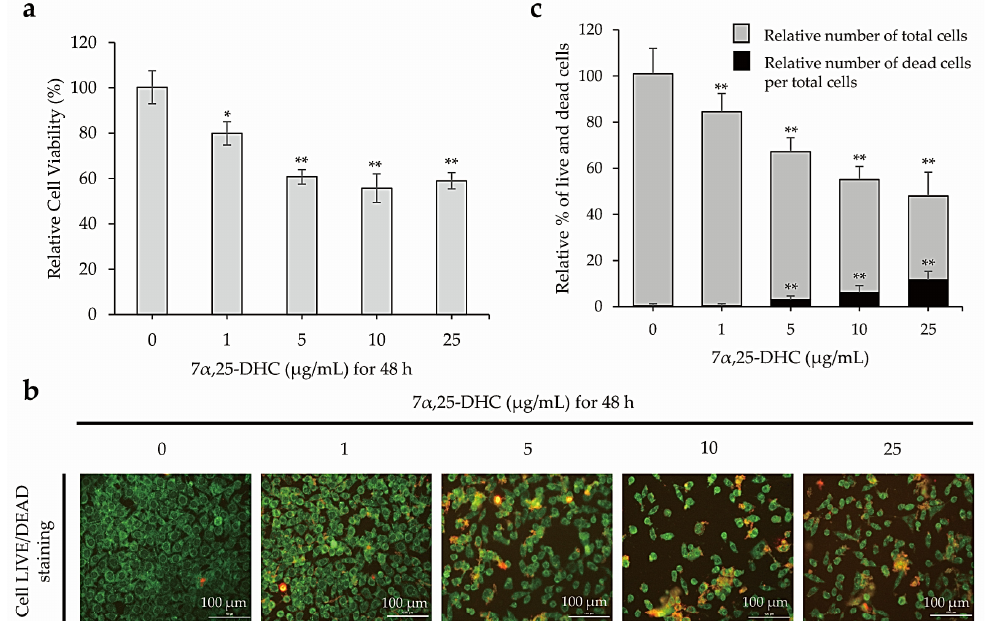
Figure 2. Cell death was increased in L929 cells treated with 7 α ,25-DHC. MTT assays and live/dead cell staining were performed to verify cytotoxicity and cell survival, respectively, in L929 cells incubated with 1, 5, 10, and 25 µ g/mL 7 α ,25-DHC for 48 h. ( a ) Cytotoxicity was increased in L929 cells incubated with 7 α ,25-DHC. ( b ) 7 α ,25-DHC decreased the survival of L929 cells. Live cells were stained as green fluorescence by green calcein AM. Dead cells were stained as red fluorescence by ethidium homodimer-1. ( c ) Cell survival was decreased by 7 α ,25-DHC exposure of L929 cells. Histogram presents the relative % of total cells (gray color) including live and dead cells. In addition, relative % of dead (black color) cells per total cells was calculated by (number of dead cells/(number of live cells + number of dead cells) × 100). Results are mean ± standard deviation of three independent experiments, * p < 0.05 and ** p <